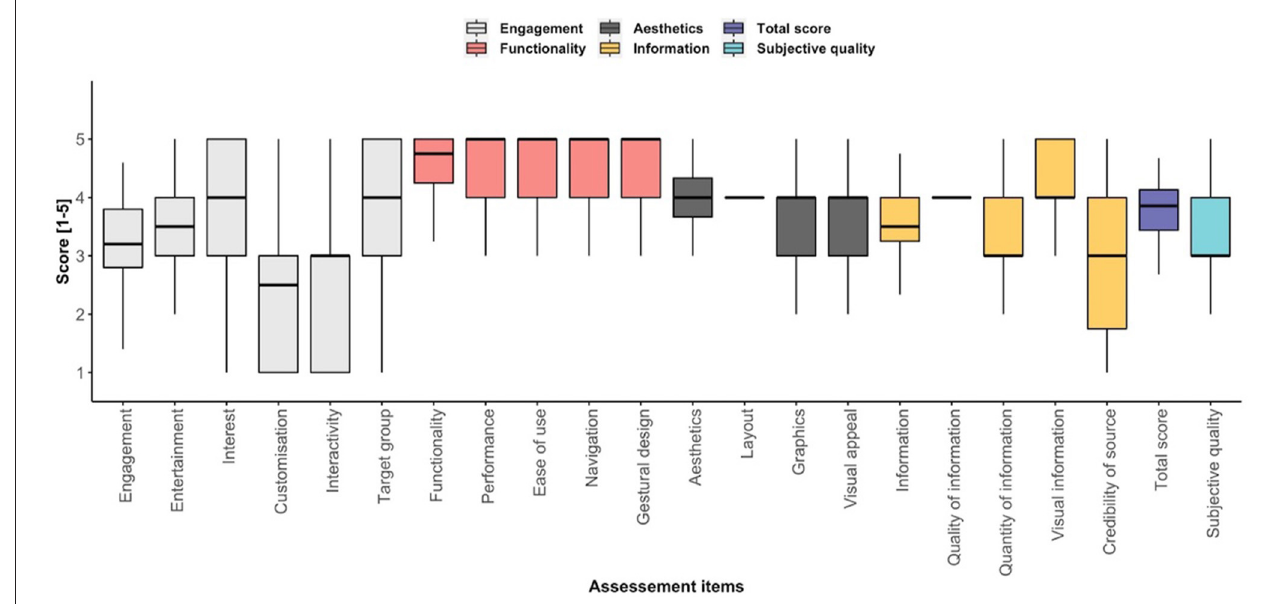
FIGURE 4 | Box plots of single uMARS subdomain items, total score and subjective